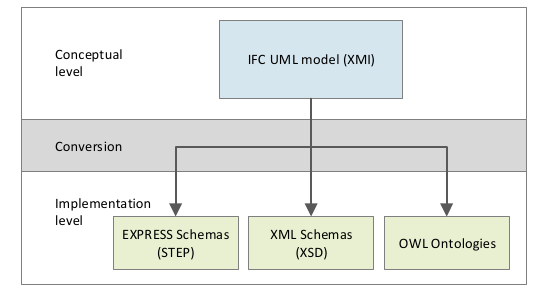
Figure 5. The Model-Driven approach for IFC. Adapted from (van Berlo,